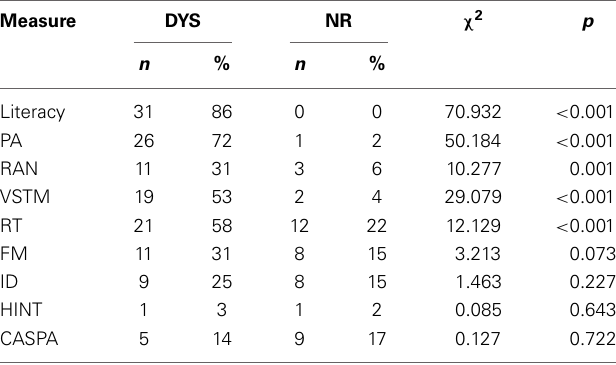
Table 6 | Individual deviancy analysis for each variable.